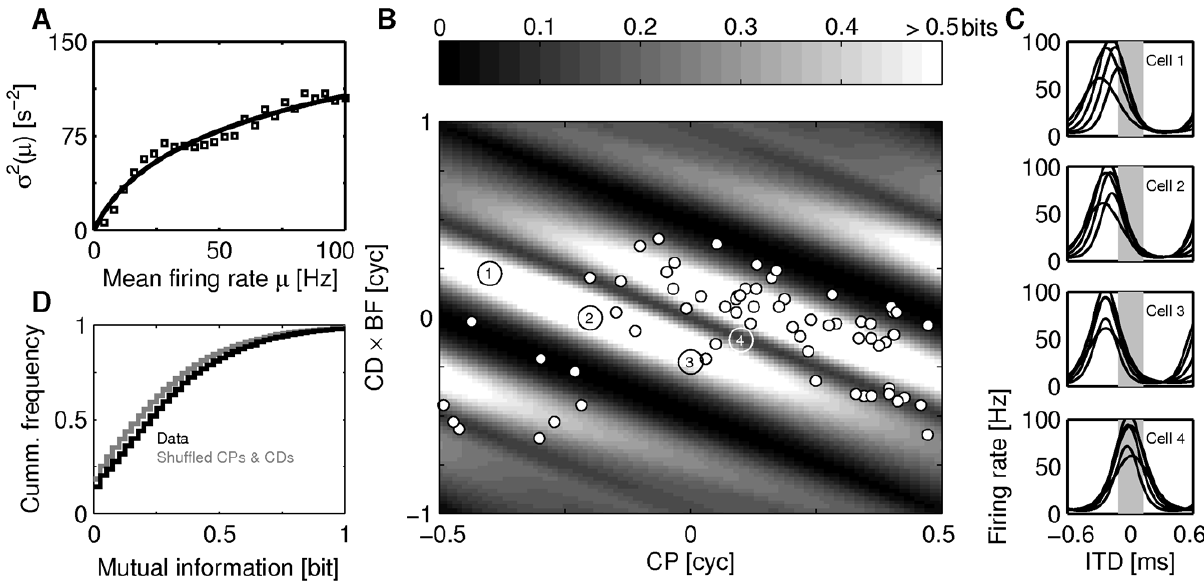
Figure 2. Rate statistics and mutual information. (A) Variance s 2 of the rate distributions as a function of mean firing rate m (squares averaged over all 153 neurons) and a logarithmic fit (solid line). For low rates the slope of the variance is consistent with a Poisson process (see Materials and Methods). (B) Mutual information (MI; grey levels) as a function of CP and CD | BF for average fit parameters of the tone delay function in the best frequency band between 800 and 1000 Hz . Circles illustrate the distribution obtained from the DNLL population in this best frequency band. (C) Firing rate as a function of ITD for four exemplary combinations of CP and CD (large circles with numbers in B). Grey bars indicate the physiological range of ITDs. (D) Cumulative distributions of mutual information of the real CP- CD | BF pairs (black) and for 1000 repetitive shuffles of CP and CD | BF (grey).